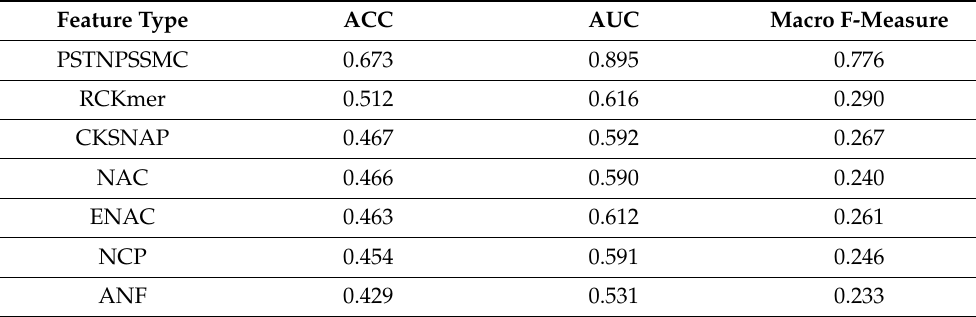
Table 1. Performance using LightGBM on a single representation under 5-fold cross-validation. Feature Type